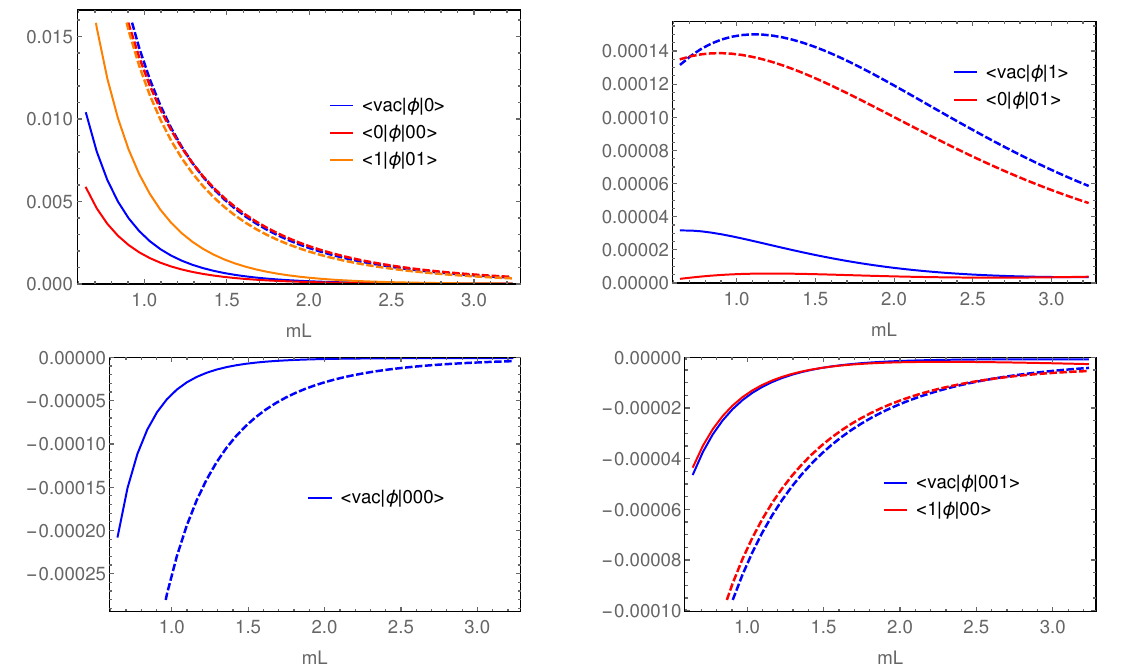
Figure 6 . Theoretical predictions in sinh-Gordon model for various (cid:12)nite volume form factors of the (cid:12)eld (cid:30) , as compared to numerical TCSA data (the latter is subtracted from each data set) at b = 1. Polynomial (Pozsgay-Tak(cid:19)acs) results are depicted by dashed curves, while the results containing the (cid:12)rst exponential corrections, conjectured by the present article, are shown by continuous curves. In the plots regarding the (cid:12)nite volume form factors ((cid:12)gures 6 and 7), the numerical TCSA data is subtracted. Then the \error" of the polynomial (3.11) approximation (more precisely, its di(cid:11)erence from TCSA numerics), as calculated from (3.7) and (3.11), is shown by dashed lines. Solid curves depict the results of the present paper ((3.21),